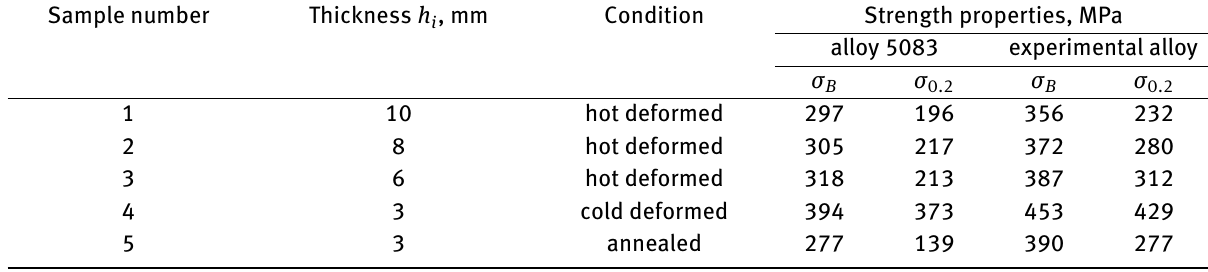
Table 3: Strength properties of samples of rolled products from experimental alloys Sample number